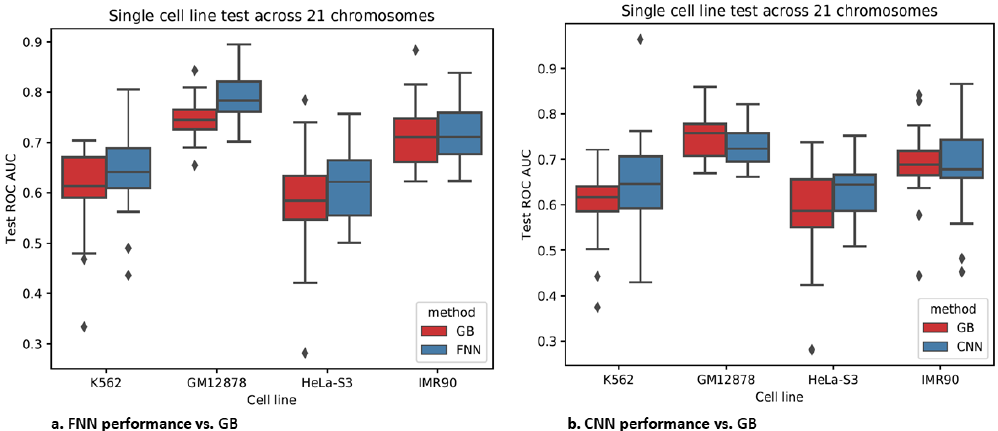
Figure 8. FNN and CNN prediction performance for the same data format as that for GB.